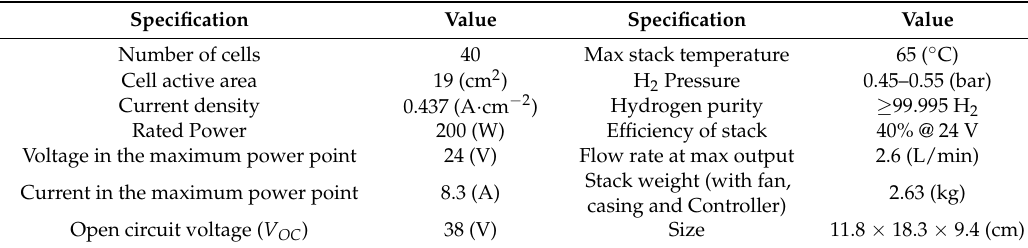
Table 5. Fuel Cell FCS-C200 specifications